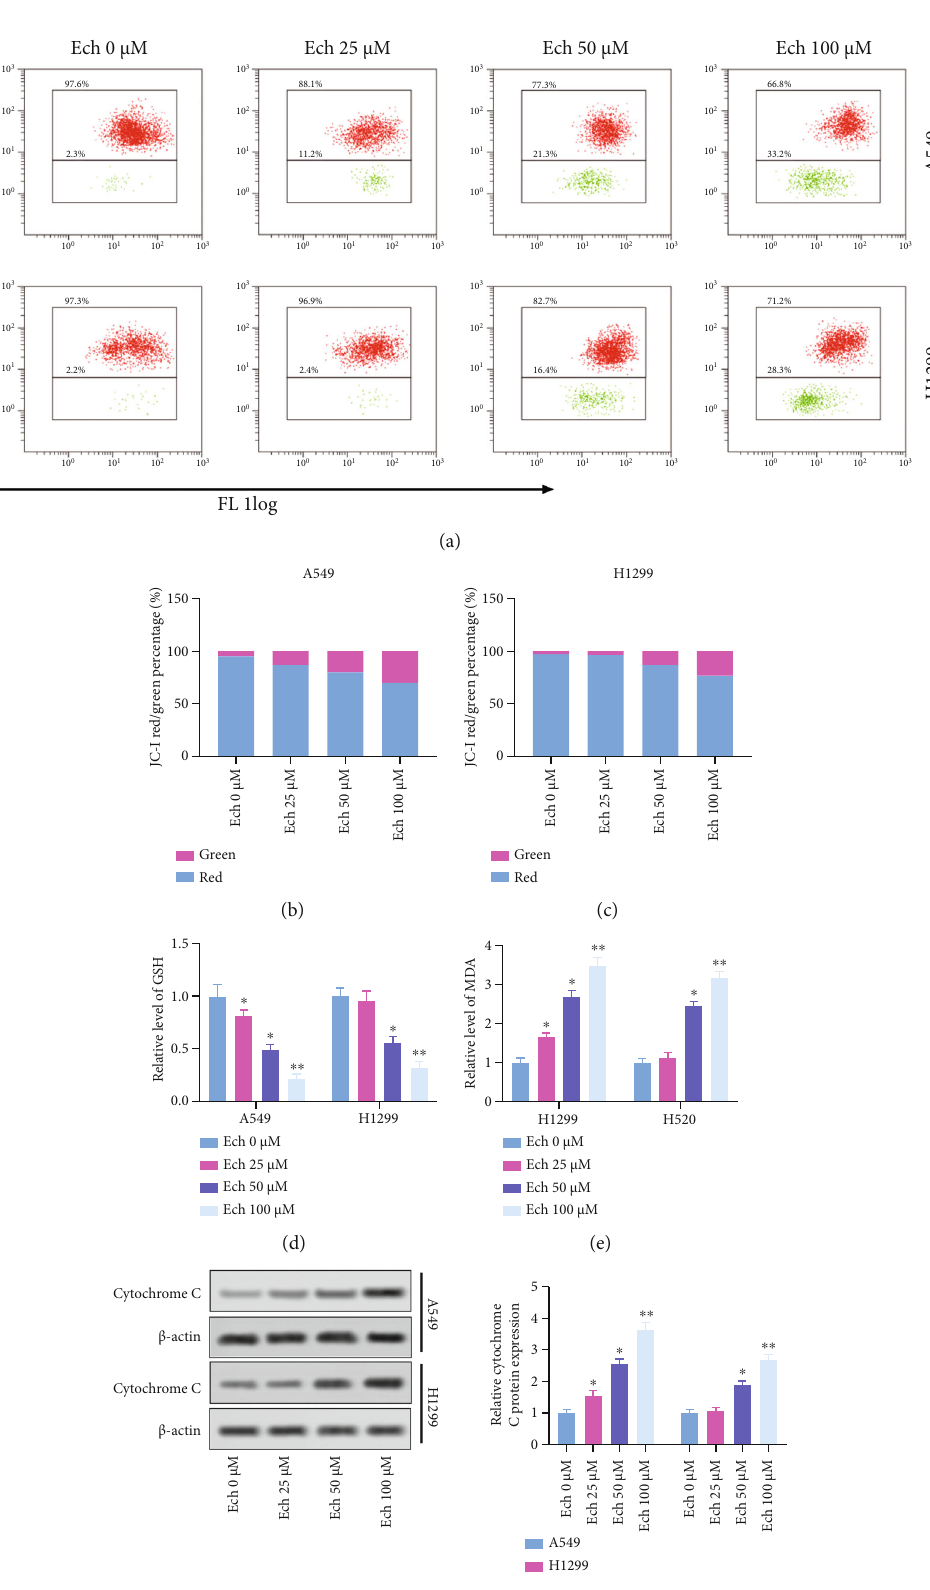
Figure 3: Ech led to mitochondrial dysfunction in NSCLC cells. (a) The mitochondrial membrane potential was detected by JC-1 staining. (b, c) Evaluation of mitochondrial membrane potential. (d, e) Oxidative stress markers (MDA and GSH) were assessed. (f) Cytochrome c release during Ech treatment was detected by western blot. Data were represented as mean ± SD . ∗ P < 0 : 05 and ∗∗ P < 0 : 01